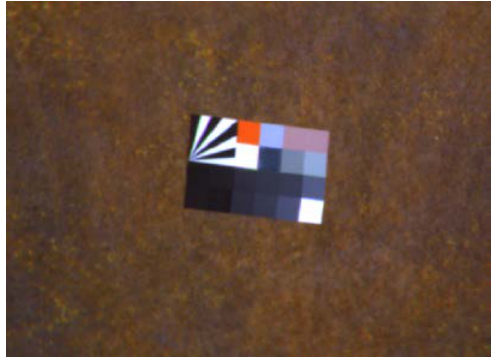
Figure 12. The PIQuAT- image obtained with miniMCA, (composition IR1-IR2-R)